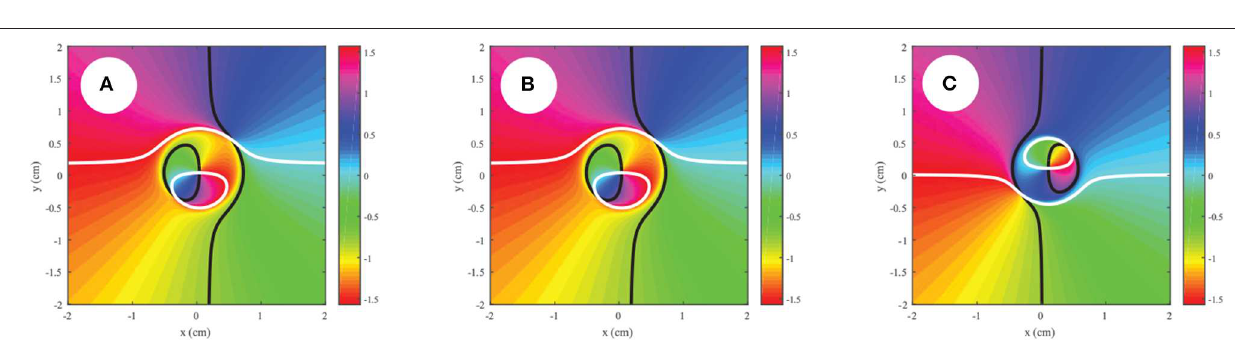
FIGURE 5 | Behavior of a partially coherent polarization singularity as the spatial coherence is decreased, with (A) δ t R 1, t L 0 and the observation point is taken at r P = =